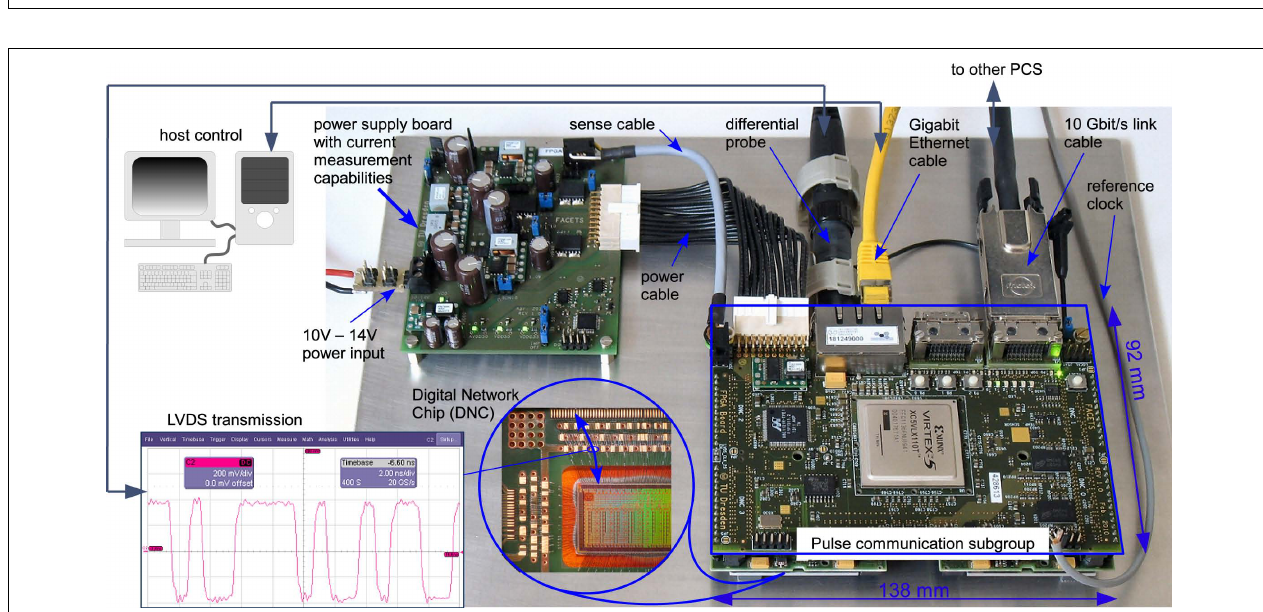
FIGURE 6 | Block diagram of the logical FPGA structure (Hartmann et al., 2010).